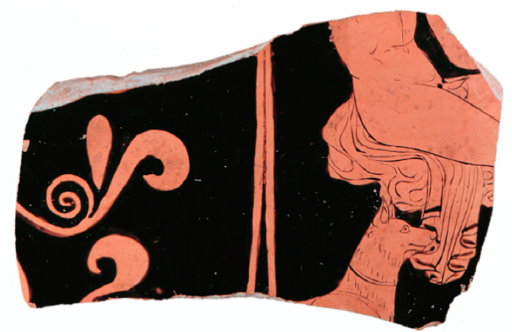
Figure 6. Nude youth with head and tail of dog (APM inv. no. 2501); vase fragment; Tarentum, Southern Italy; ca. fourth century. Photo by Michiel Bootsman; image courtesy of the Allard Pierson Museum, Amsterdam.